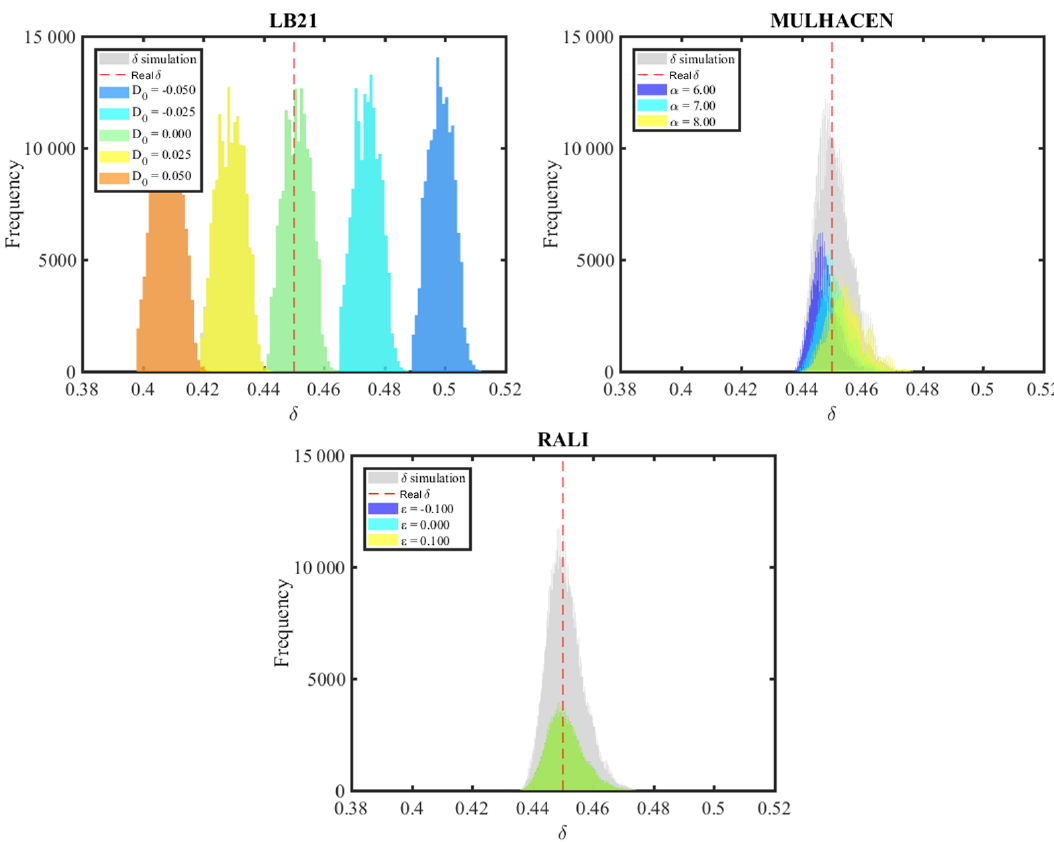
Figure 11. Histogram of the simulated δ values for LB21, MULHACEN, and RALI, with coloured sub-histograms indicating the contribution at certain parameter values of α , D O , and ε values. Dashed lines represent δ r at 045.